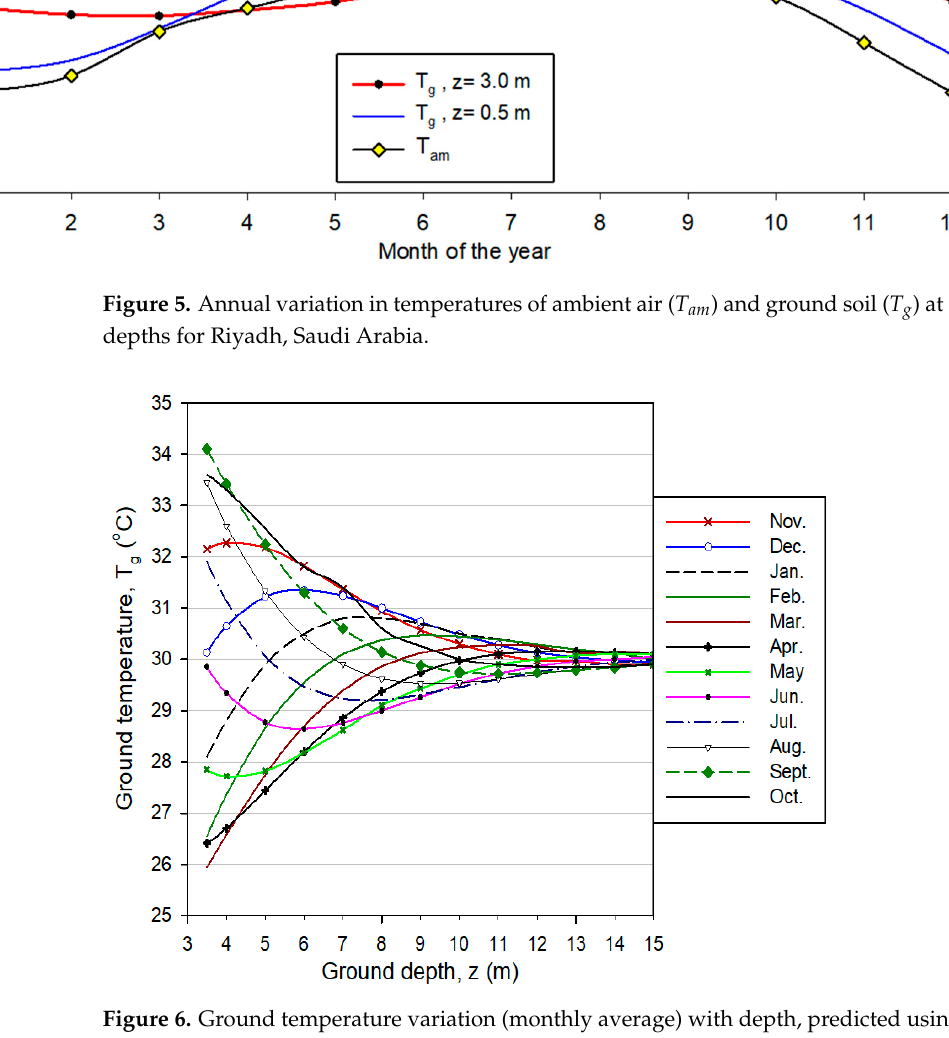
Figure 6. Ground temperature variation (monthly average) with depth, predicted using Equation (1) for the KSA desert.